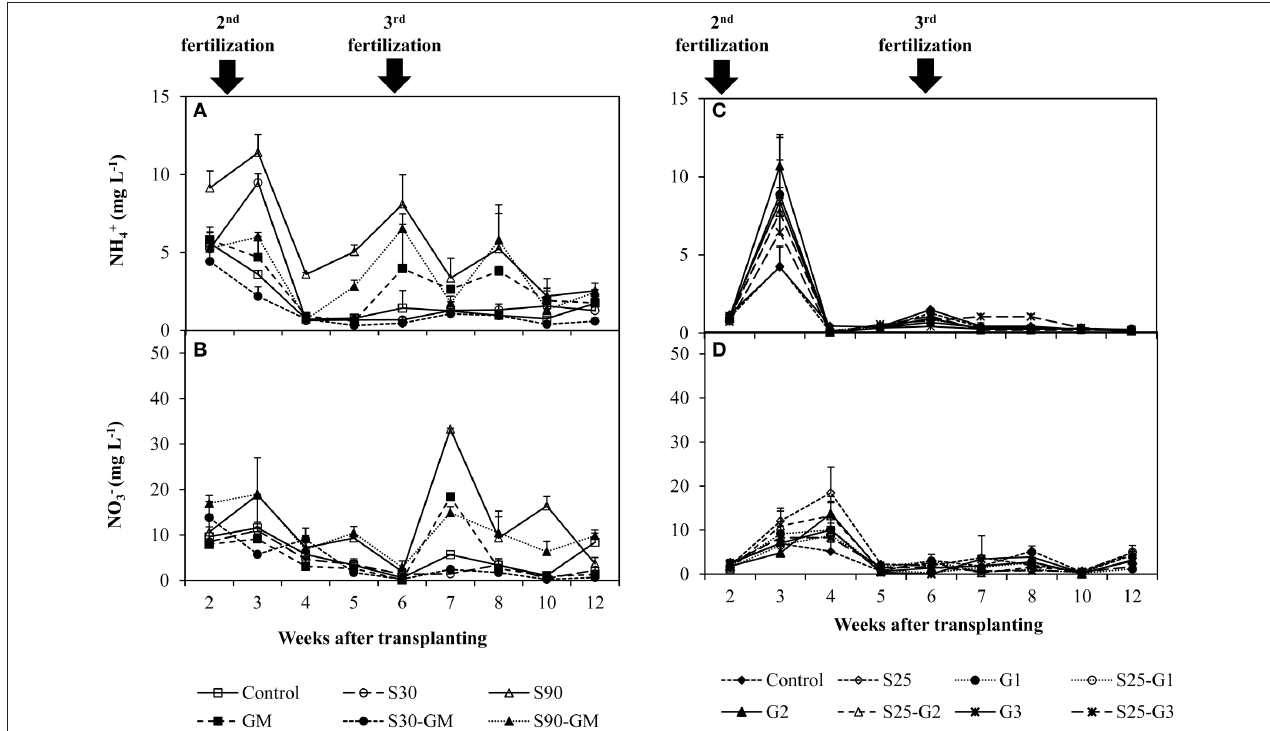
FIGURE 2 | Changes of NH + 4 and NO − 3 concentration under the addition of gypsum and different salinity levels. (A,B) for Experiment (I) and (C,D) for Experiment (II). Error bars indicate standard